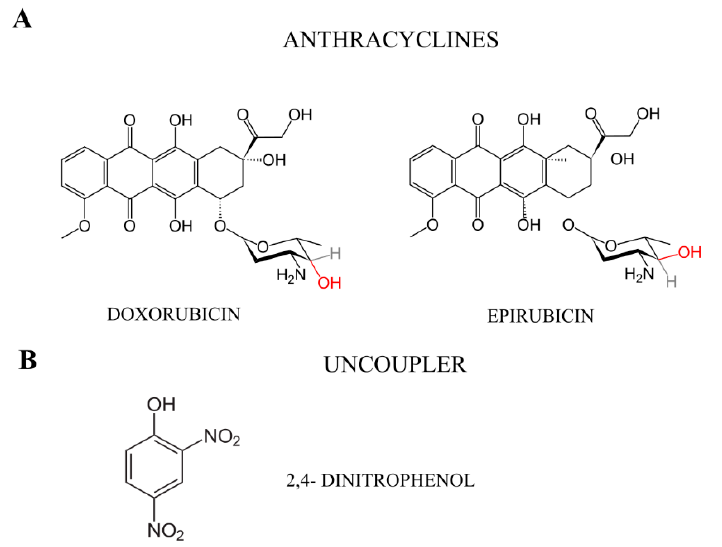
Figure 1. Chemical structures of ( A ) anthracyclines (doxorubicin and its derivative—epirubicin). and ( B ) uncoupler—2,4-dinitrophenol. ( B )